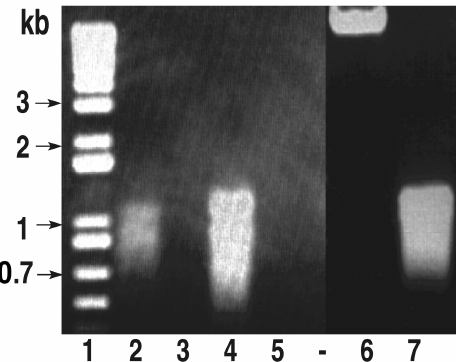
Figure 6. Protease-treated cells are resistant to DNaseI. Lane 1: 1 kb DNA ladder standards; Lane 2: DNA from protease-treated cells, sonicated, then incubated with DNaseI; Lane 3: empty; Lane 4: DNA from protease-treated cells incubated with DNaseI; Lane 5: empty; Lane 6: chromosomal DNA isolated from fresh A. fulgidus cells; Lane 7: DNA from untreated whole cells.